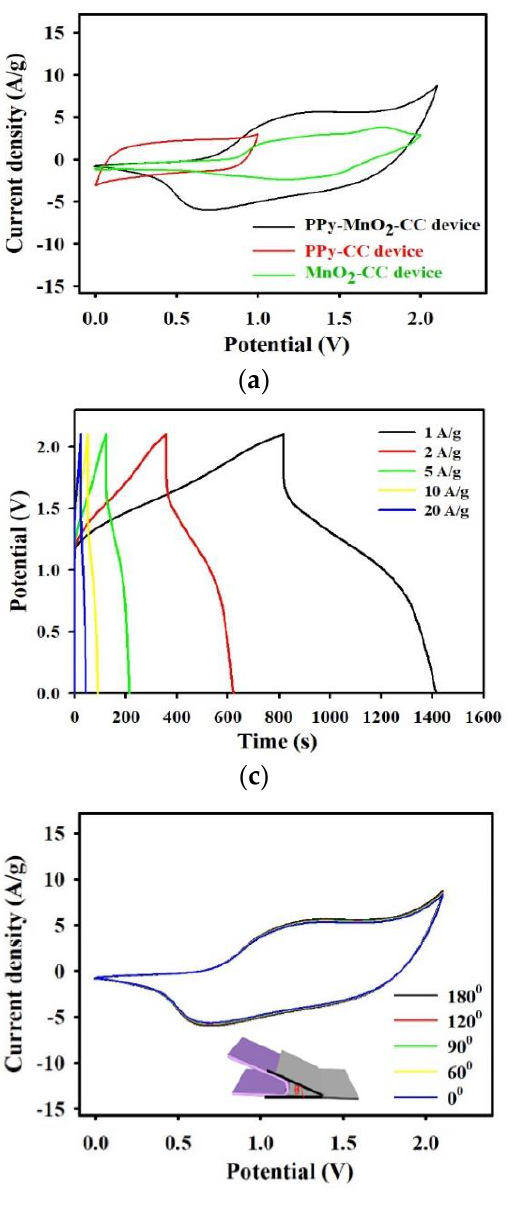
( b ) Figure 6. ( a ) Ragone plots of the PPy-MnO 2 -CC flexible SSC device. ( b ) Blue LED operated by a single device.